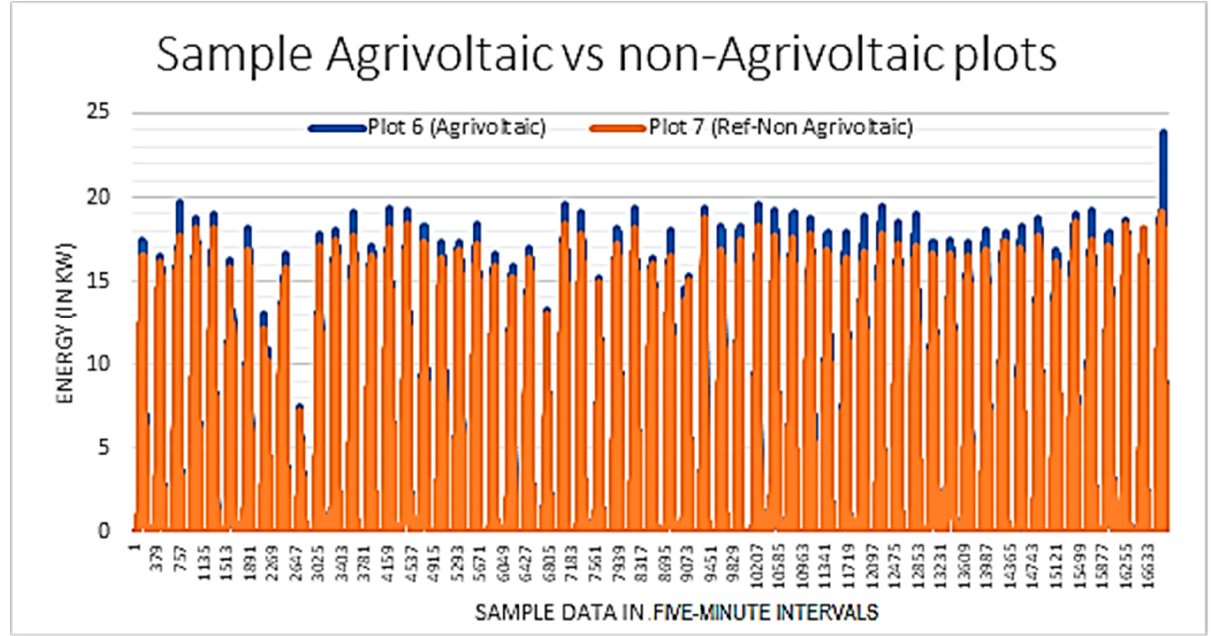
Figure 12. Sample agrivoltaic vs. non-agrivoltaic plots. Table 3. The electrical output for the seven selected plots.